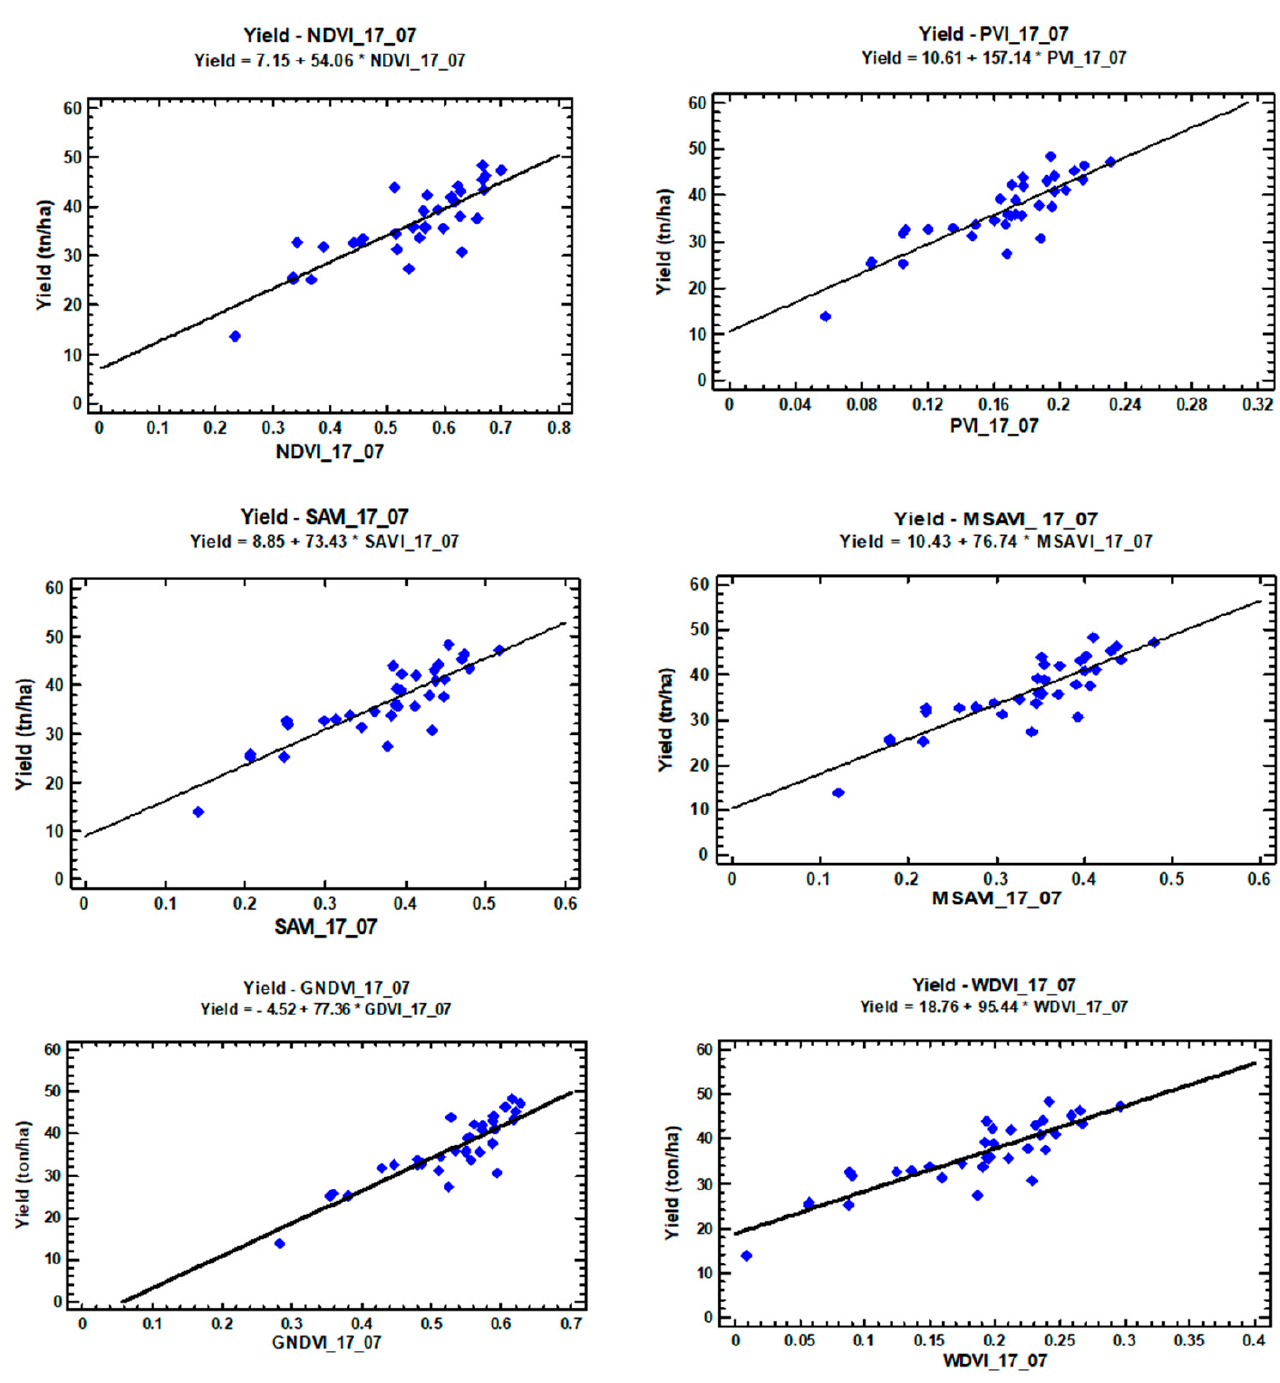
Figure 6. The linear regression models that describe the relationship between the selected single-date (17_07) VI mean (field-level) values and the corresponding recorded yield (likewise for each field).